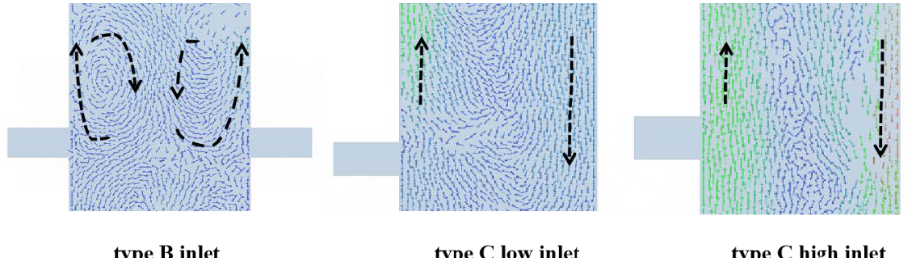
Figure 13. Instantaneous velocity vectors at the inlet of different feed structures.